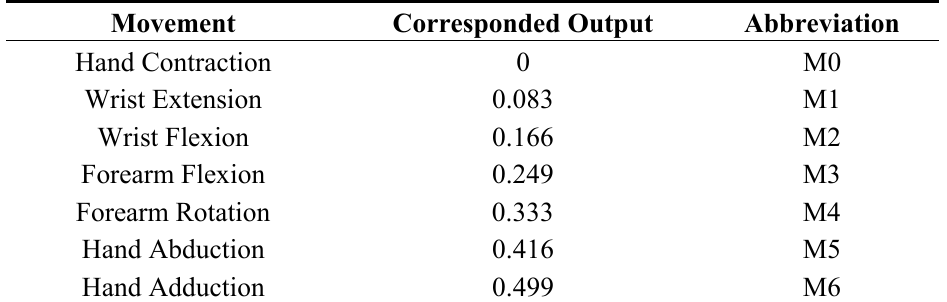
Table 2. Network output values associated with the recognized